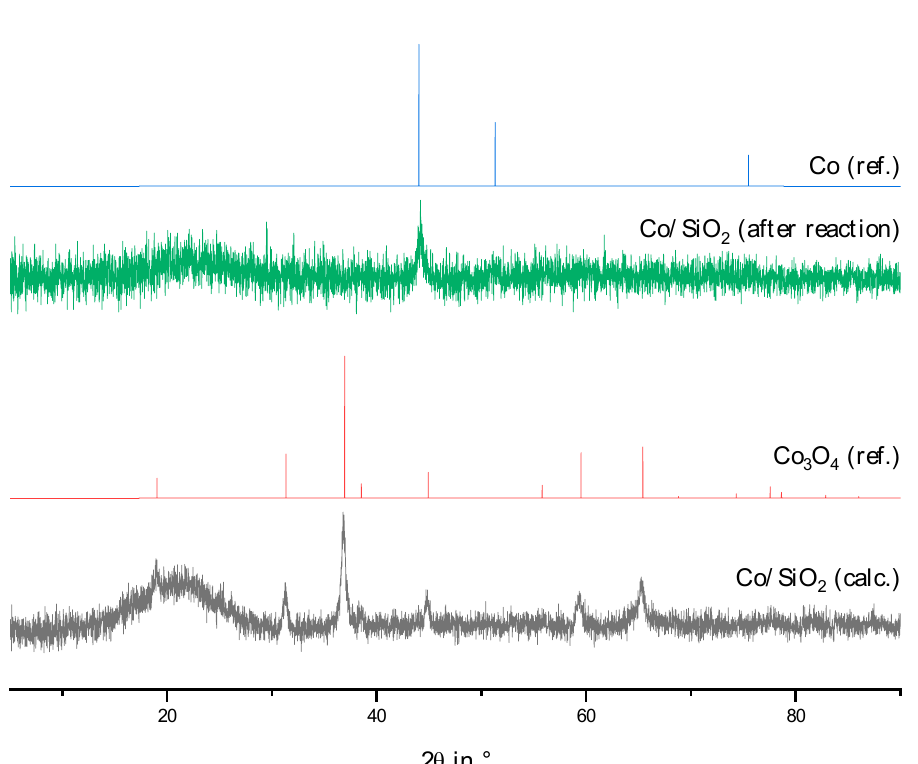
Figure A5. P-XRD of calcined rhenium catalyst before reaction (calc.) and after reaction.